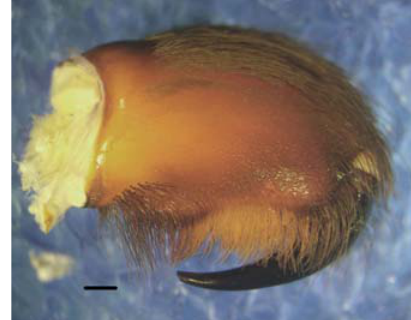
1.0mmImage 11. Chelicerae teeth. Scale 1.0mm